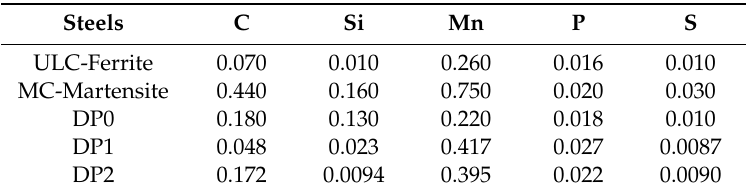
Table 1. Chemical composition (in wt.%).